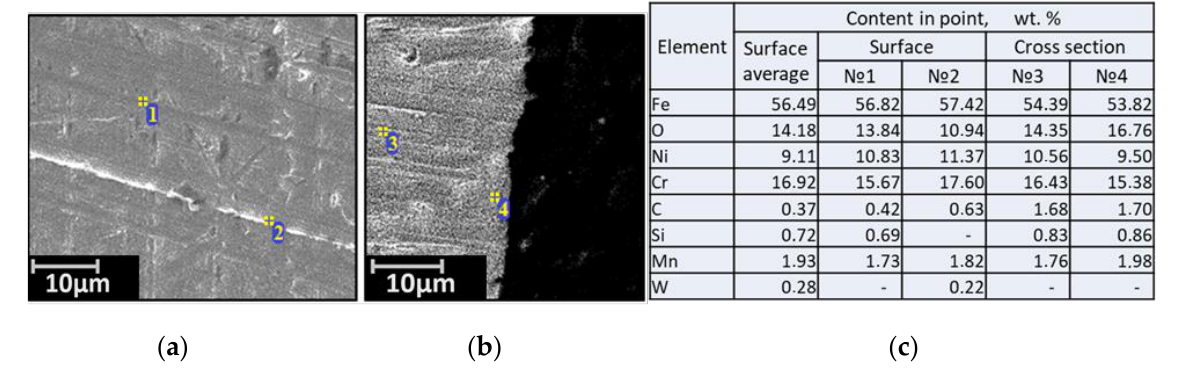
Figure 1. Micrographs of the surface ( a ), the cross-section ( b ), and the elemental composition ( c ) of the source material steel 12Cr18Ni10Ti.